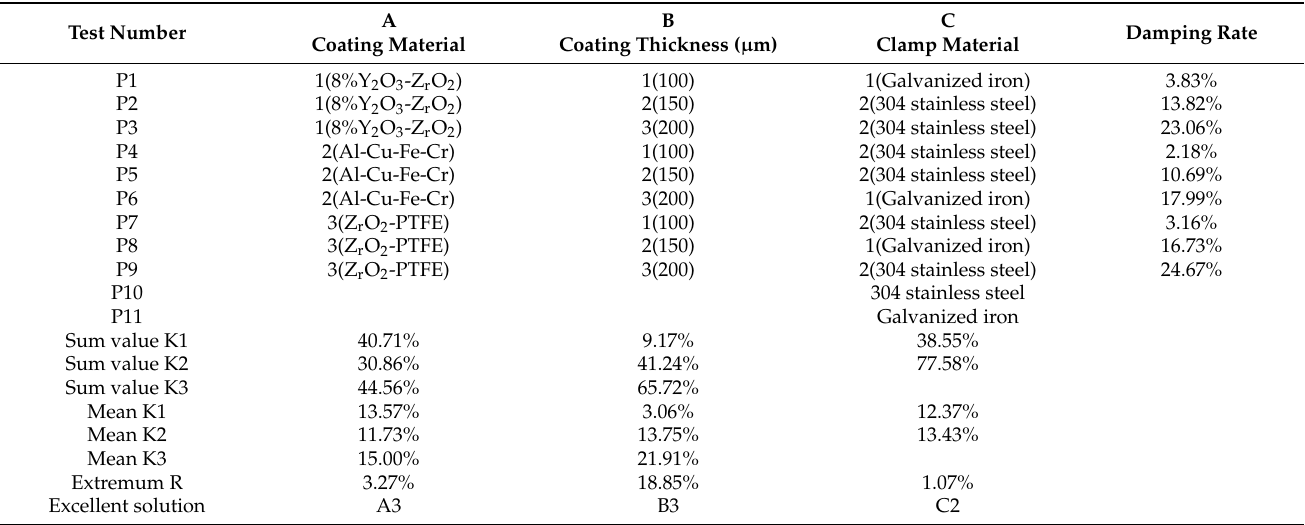
Table 11. Orthogonal test results of vibration response under high-voltage 200 Hz fixed-frequency excitation.